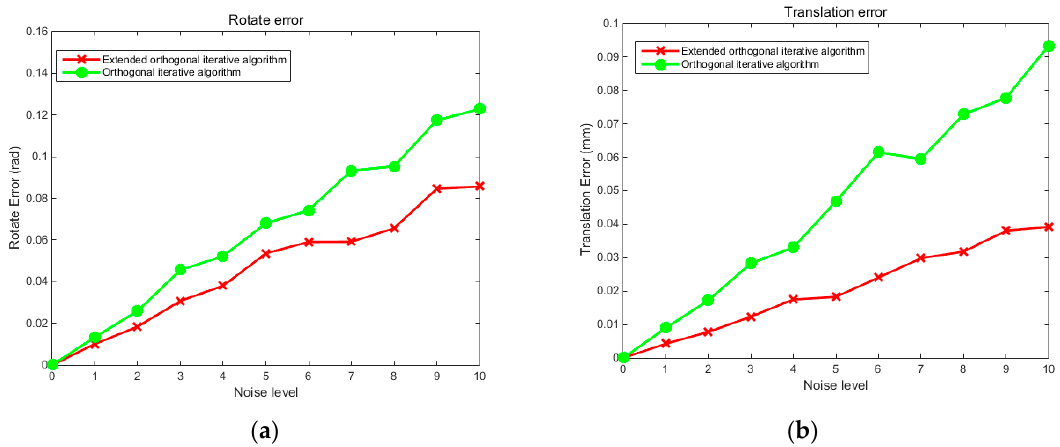
Figure 3. error curve of the rotation angle and translation affected by noise. Graph ( a ) shows the RMS error curve of rotation angle at different noise levels, and graph ( b ) shows the RMS error curve of translation at different noise levels.